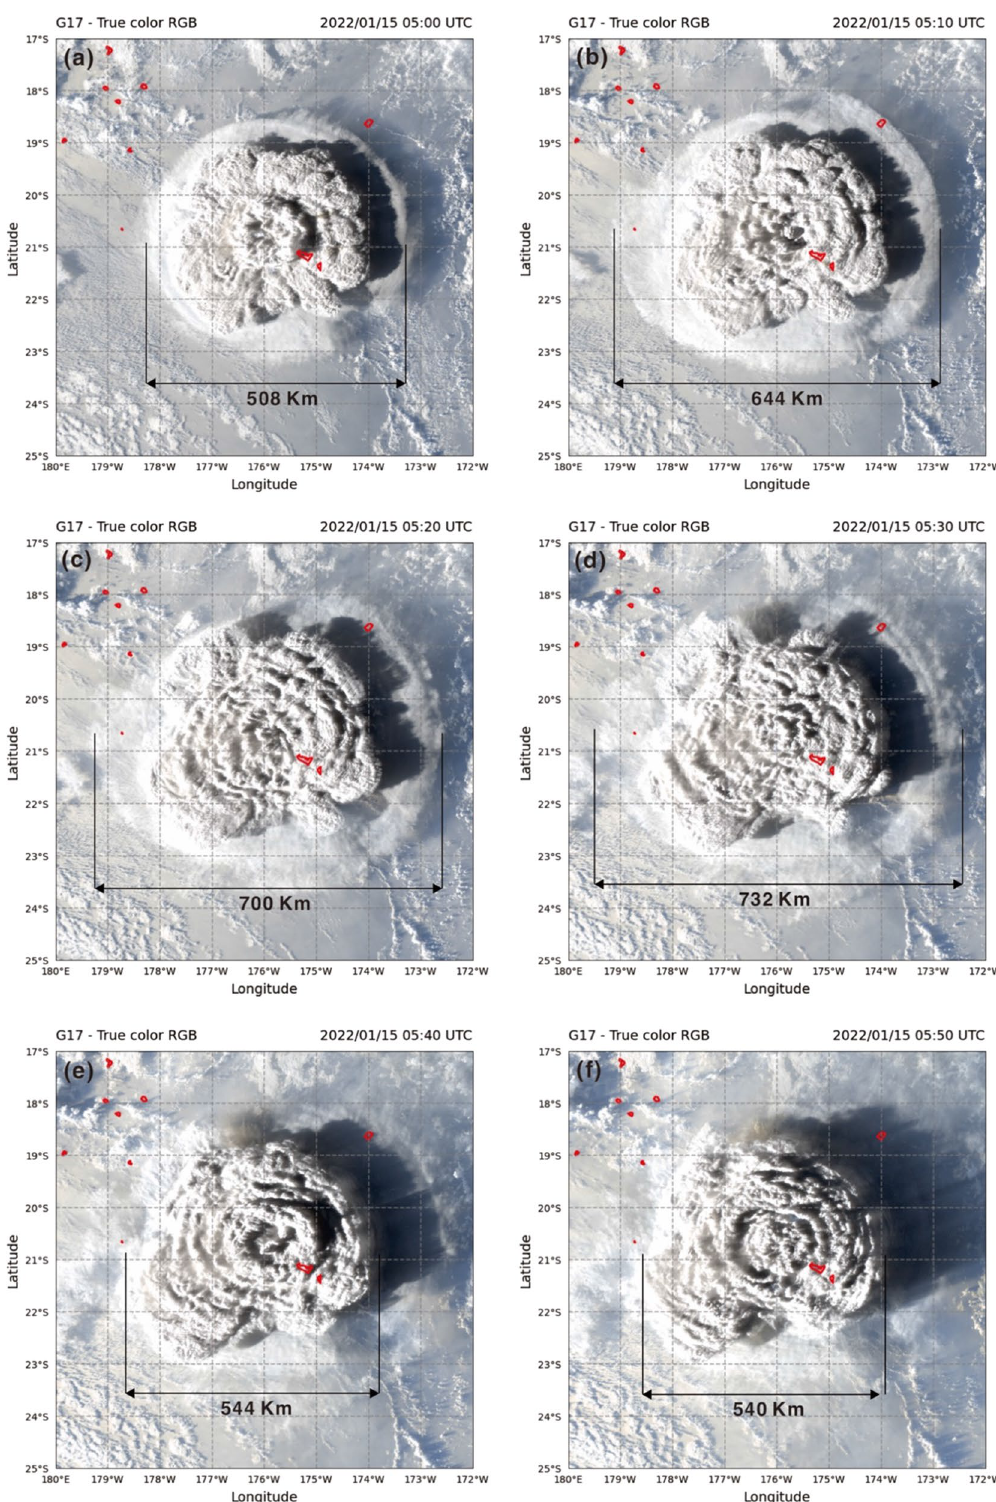
Fig. 10 True color RGB using GOES-17 from 05:00 to 05:50 on 15 January 2022. ( a ) 2020/01/15 05:00 UTC, ( b ) 2020/01/15 05:10 UTC, ( c ) 2020/01/15 05:20 UTC, ( d ) 2020/01/15 05:30 UTC, ( e ) 2020/01/15 05:40 UTC, ( f ) 2020/01/15 05:50